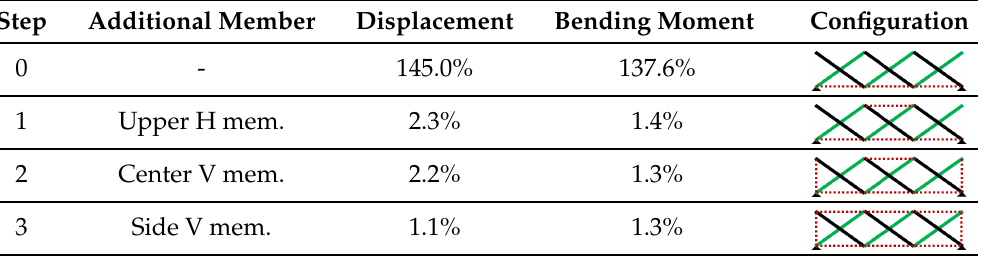
Table 3. Optimal reinforcing procedure for three scissors unit